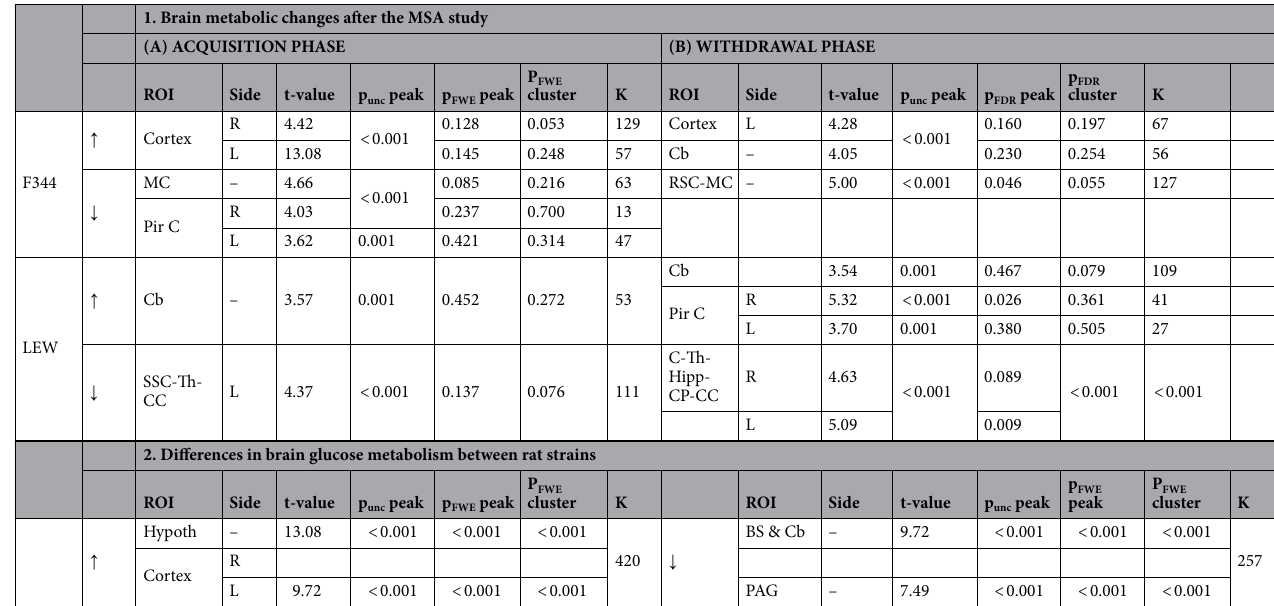
Table 1. (1) Brain metabolic changes in F344 and LEW animals after MSA study. The comparison shows differences in glucose brain metabolism between morphine-treated animals and saline-treated animals, in the acquisition phase (1.A) and the withdrawal phase (1.B). (1.A) F344-morphine animals showed higher FDG uptake in the cortical area and lower FDG uptake in the motor and piriform cortex than the F344- saline animals. LEW-morphine animals showed lower FDG uptake in the somatosensorial and cingulate cortex and the thalamus and higher FDG uptake in the cerebellum than the LEW-saline animals. (B) F344- morphine animals showed higher FDG uptake in the left cortex and cerebellum and lower FDG uptake in the restrosplenial and motor cortices than the F344-saline animals. LEW-morphine animals showed higher FDG uptake in the cerebellum and piriform cortex and lower FDG uptake in the cortex, thalamus, hippocampus, and caudate putamen than the LEW-saline animals. (2) Differences in brain glucose metabolism between LEW-Sal animals and F344-Sal animals. Saline-LEW animals showed higher FDG uptake in the hypothalamus and the cerebral cortex and lower FDG uptake in the brainstem, cerebellum and PAG than Saline-F344 animals. ROI: Region of interest. Side: left (L) and right (R). k: cluster size, T: Student t. FDG uptake: increase ( ↑ ) and decrease ( ↓ ). p: p value (unc: uncorrected, FWE: family-wise error). Abbrev.: BS: brainstem; C: